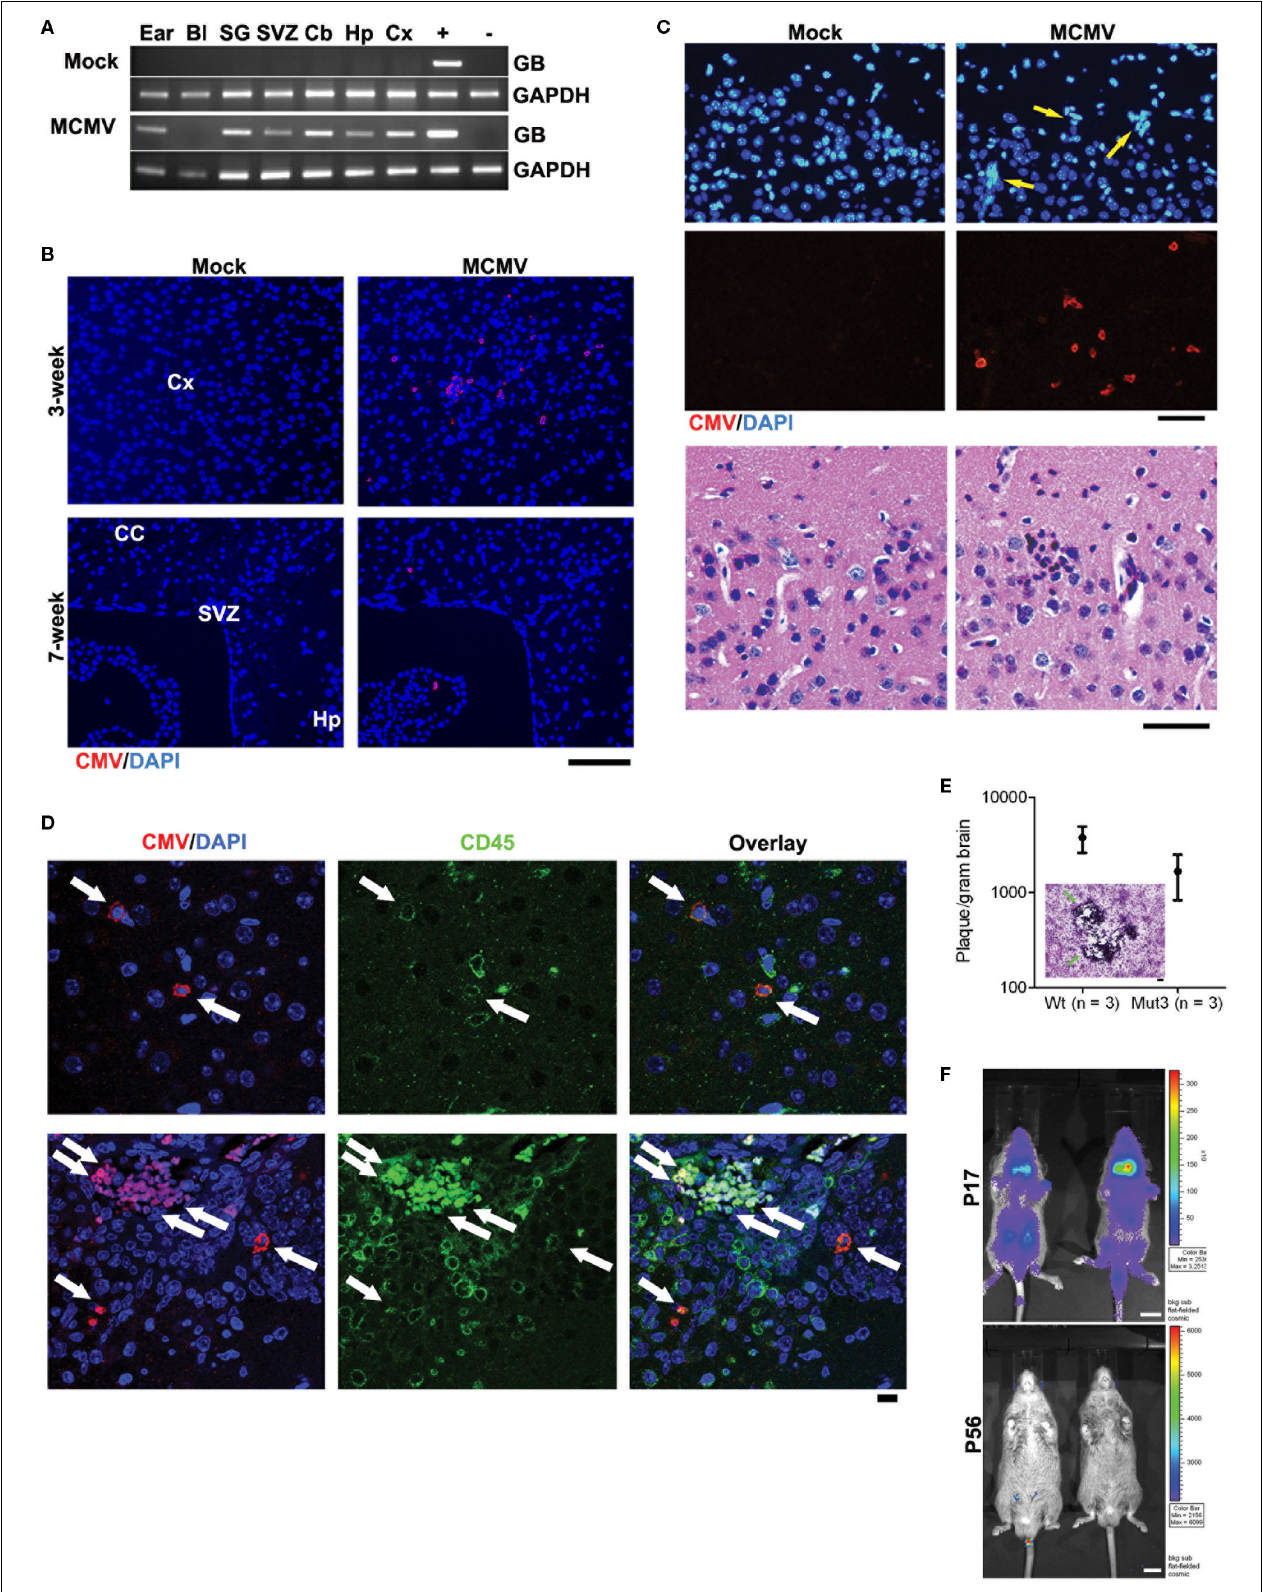
FIGURE 1 | Perinatal MCMV infection resulted in productive virus replication and CMV immunoreactivity in CD45-positive cells in the brain .